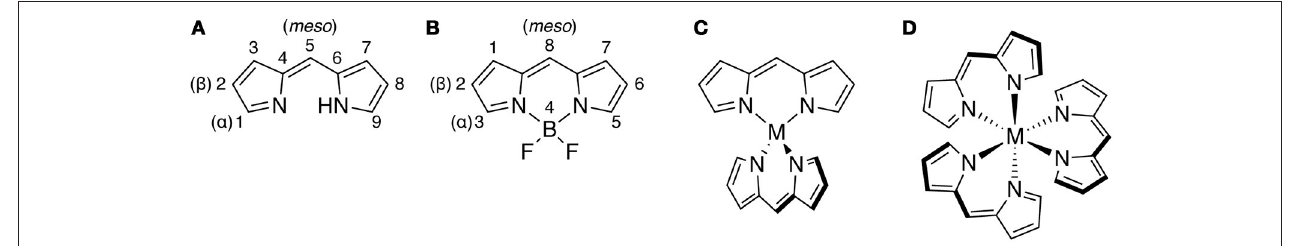
FIGURE 1 | Chemical structures of (A) dipyrrin, (B) BODIPY, (C) bis(dipyrrinato)metal(II) complex, and (D) tris(dipyrrinato)metal(III) complex. The atomic numbering scheme is shown in (A , B)